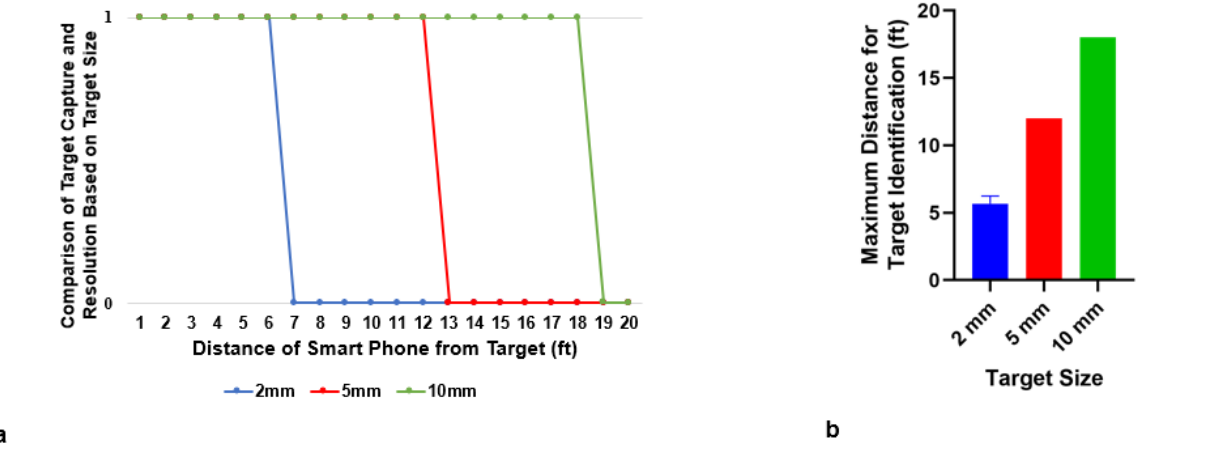
Figure 7. ( a ) Comparison of target capture and target resolution based on size. ( b ) Bar graph depicting maximum distance for target identification based on size. Table 1. Analysis of Inter-Target Resolution by ANOVA.